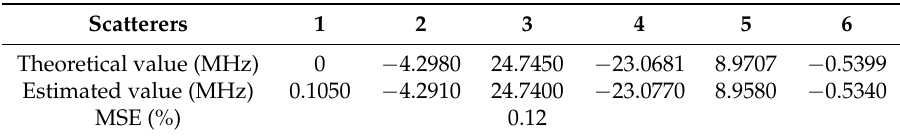
Table 1. Estimated spatial frequency and its mean-square-error (MSE) from illuminator of opportunity (IO) (A) using the proposed compressed sensing (CS) method.